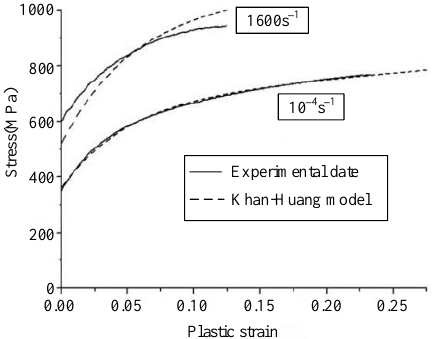
where σ is flow stress, ε p is plastic strain, reference strain rate, and m is the material constant. The relation curve between and dimensionless parameter ln Figure 4. Comparison of KH model predictions and experimental data at different strain rates [17]. In view of the above shortcomings, Equation (12) is modified to better describe the effect of strain rate on flow stress: